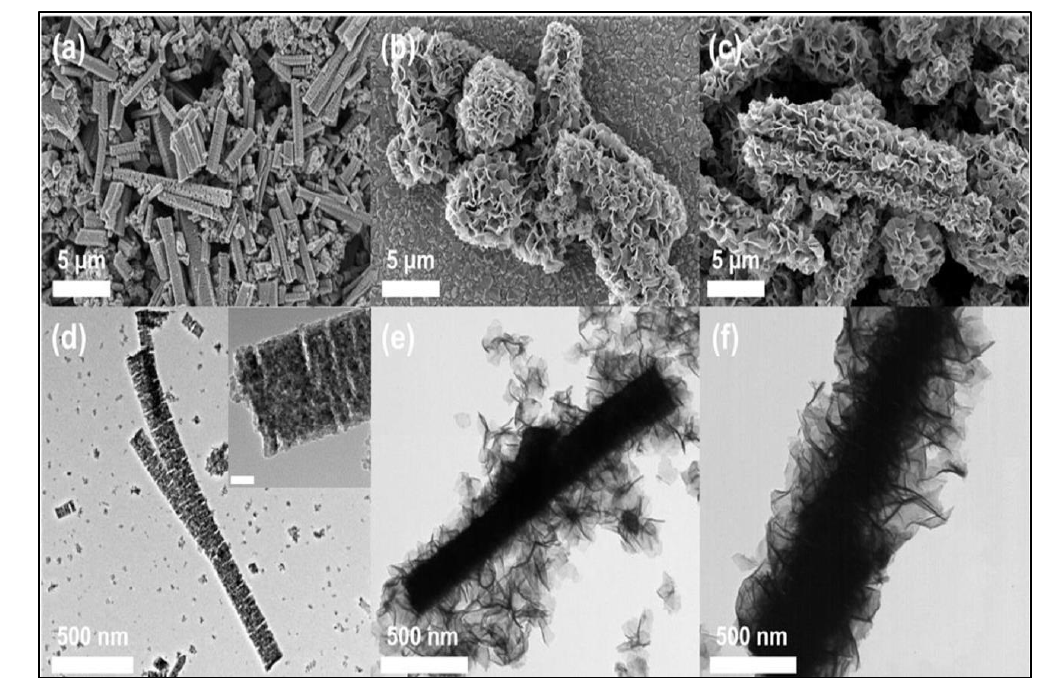
Figure 4. SEM images of ( a ) ZnO nanowires and ( b , c ) TiO 2 -NS-ZNW and TEM images of ( d ) ZnO nanowires and ( e , f ) TiO 2 -NS-ZNW. The images have been reproduced with permission [97]. Table 2. TiO 2 -NS and TiO 2 -NS composite materials for